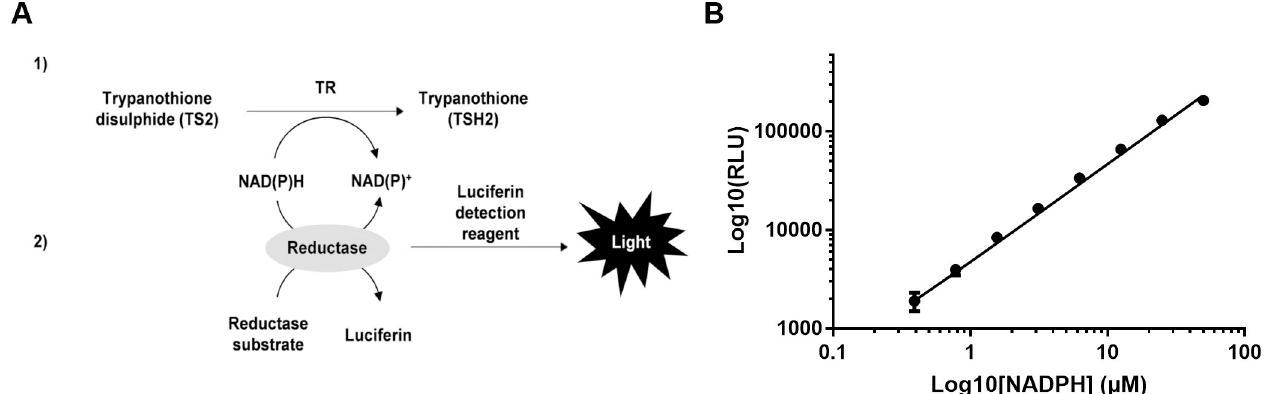
Fig 2. ( A ) Schematic representation of the TR assay reaction. The luciferase activity is dependent on the residual NADPH concentration after TR reaction (1). The luminescent signal, which is produced by the NADPH-Glo assay, is inversely proportional to the TR activity (2). ( B ) Sensitivity and linearity of the NADPH detection. The plot x- and y-axis are presented in logarithmic scale to allow a better appreciation of the serially diluted points. The linear correlation is plotted as a sigmoid curve on the log-log graph. The plotted points are the average of three independent replicates.